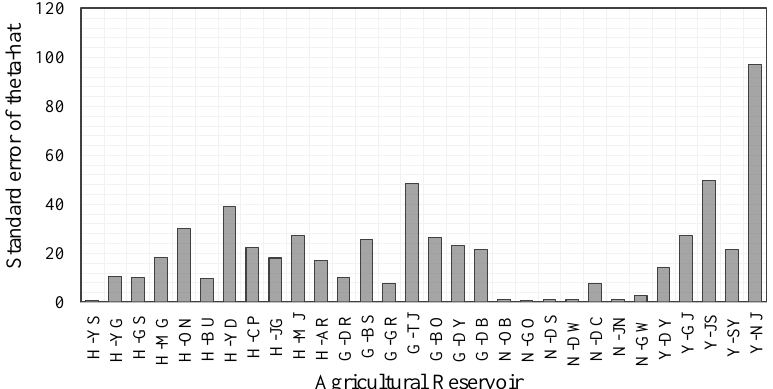
Figure 9. Standard error of ˆ θ for a 24-h duration and a 200-y return period for 2040s under the RCP4.5 scenario for 30 agricultural reservoir watersheds. The estimator (ˆ θ ) is the mean. Refer to Table 1 for reservoir names.